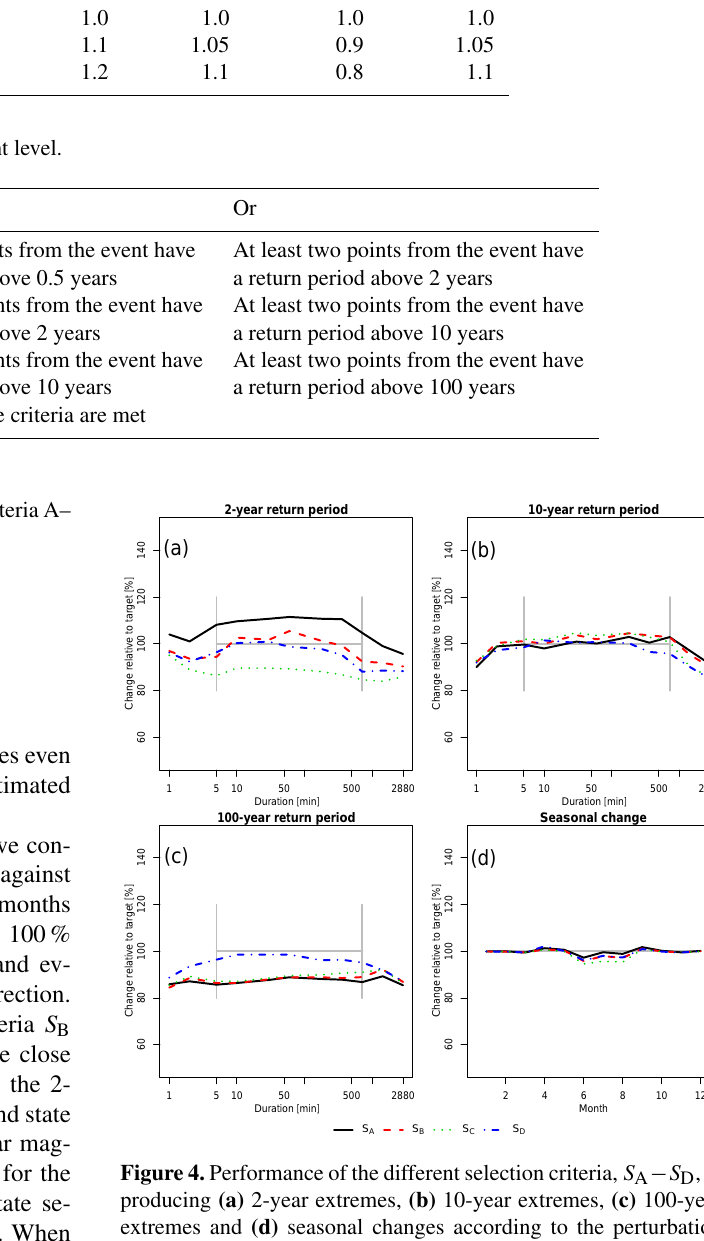
tion criteria have approximately the same performance at a level close to 100 % (Fig.